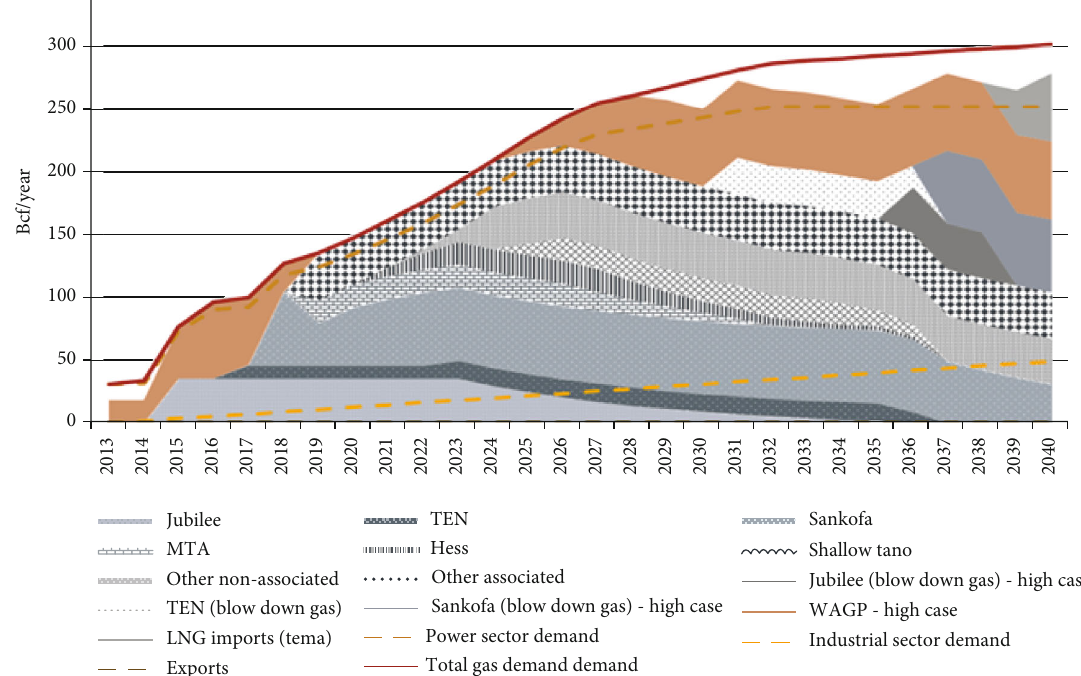
Figure 5: GNPC high-case gas supply for Ghana